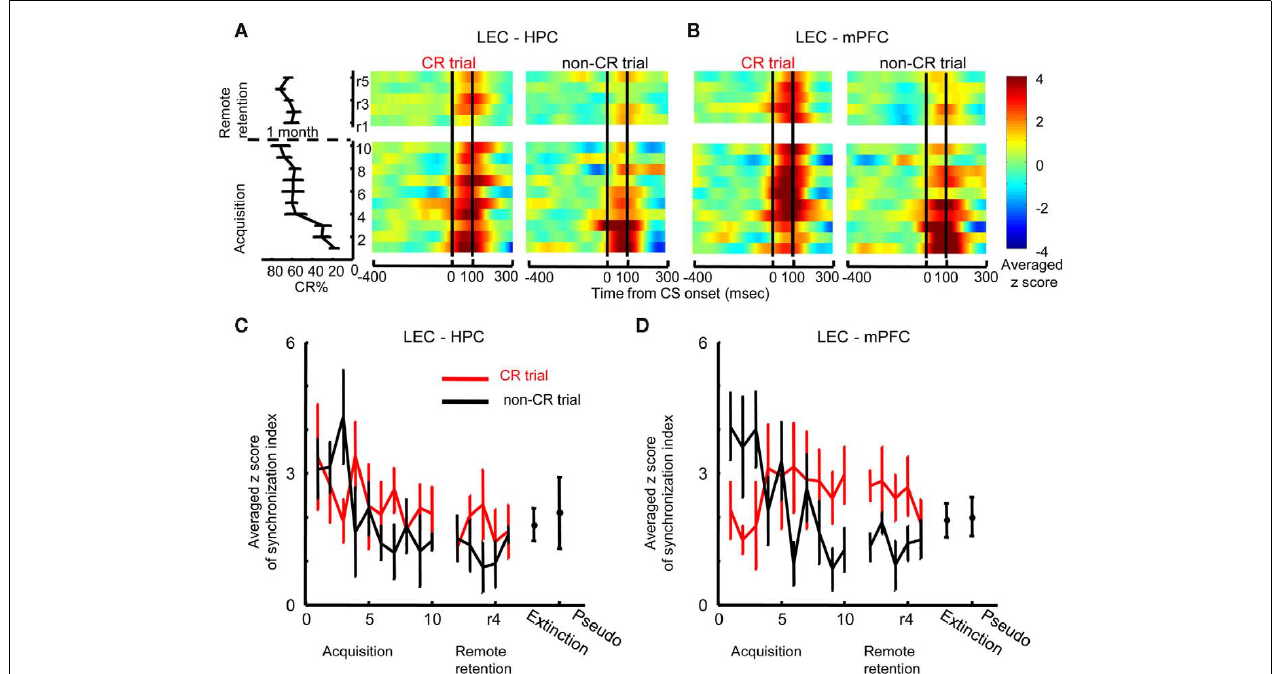
during retention sessions 1month later. (B) Theta synchronization between the LEC and medial prefrontal cortex (mPFC) was higher during non-CR trials (right) than CR trials (left); with training, however, it became stronger in CR trials than in non-CR trials and this strengthened theta synchronization was also observed during remote retention. (C,D) Time-dependent changes in theta synchronization were confirmed by the plots that represent averaged maximum z -score values for theta synchronization during acquisition (mean ± SEM from six rats) and remote retention (mean ± SEM from eight rats). Red and black lines indicate theta synchronization in CR and non-CR trials, respectively. LEC–HPC and LEC–mPFC theta synchronization was weak during extinction and pseudo-conditioning, during which the stimulus contingency was broken.